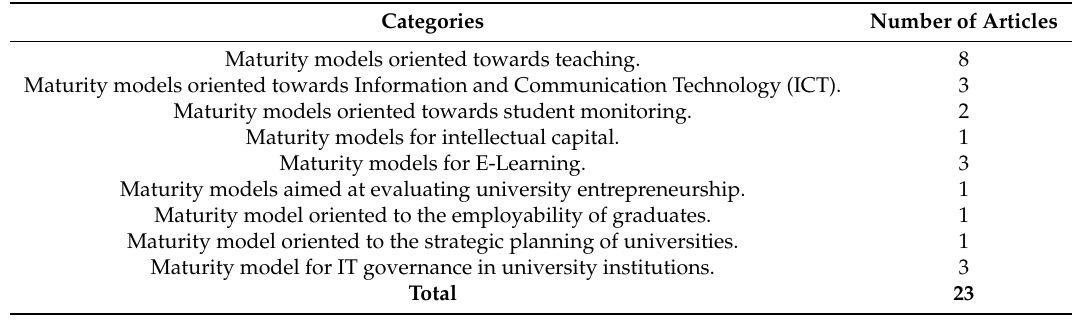
Table 3. Categories of selected Maturity